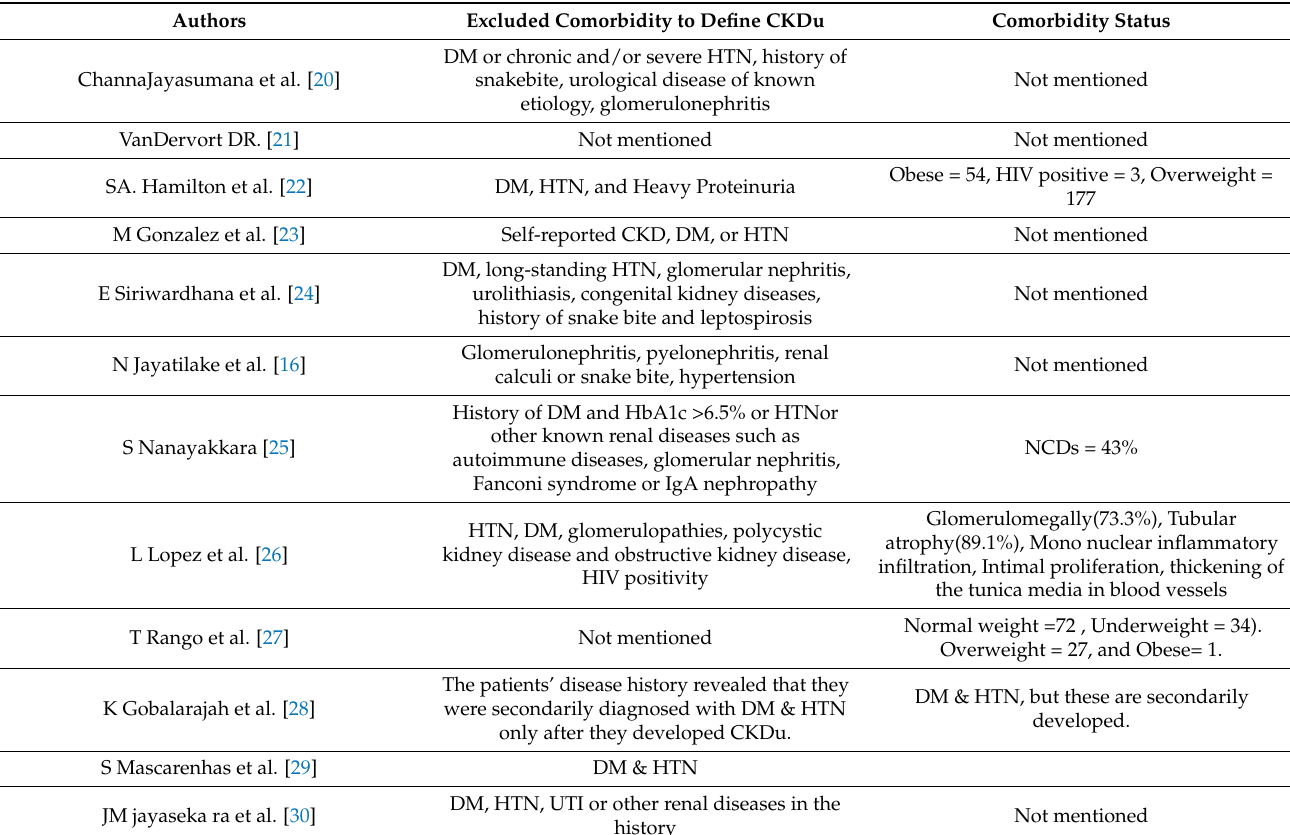
Table 2. Study information and co-morbidity status of included